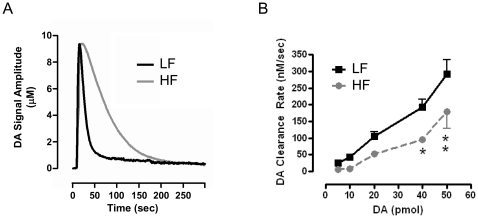
DA clearance rate is reduced in HF DIO rats.(A) Representative oxidation currents produced by intrastriatal application of exogenous DA, and converted to a micromolar concentration using a calibration factor. (B) DA clearance rates were obtained by pressure ejecting increasing pmol amounts of DA in the striatum of anesthetized LF- and HF-fed rats. (n = 4/group, two-way, repeated measures ANOVA, F1,24 = 6.843; *p<0.05; **p<0.01 by Bonferroni post-hoc analysis). Data are expressed as mean ± S.E.M.